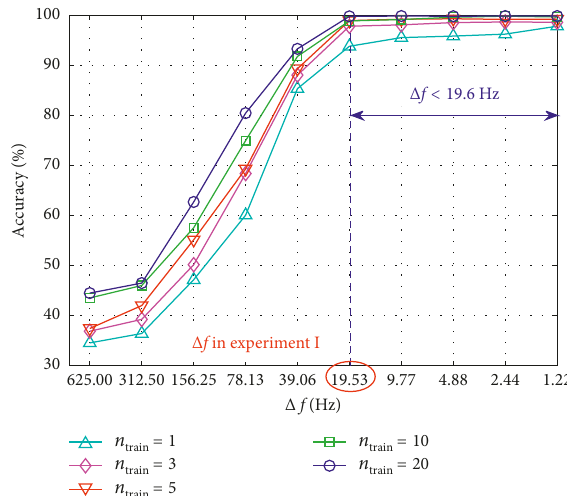
Figure 15: Classification performance of dataset A in experiment I with different spectrum resolution.